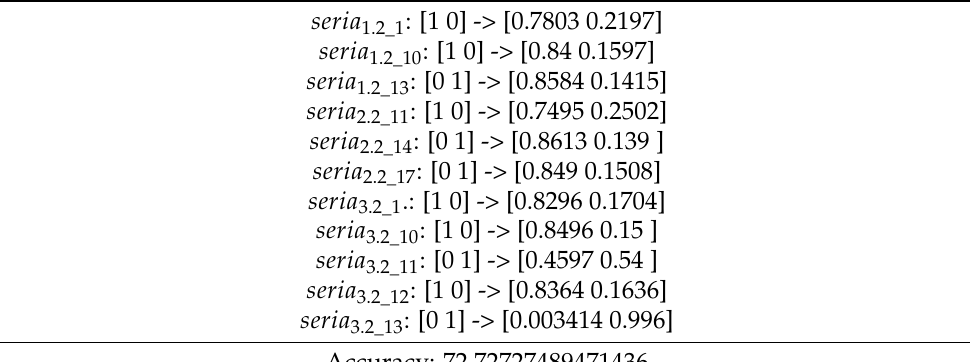
Table 15. Results for the TRN-TST sample (90 percent of sites to 10